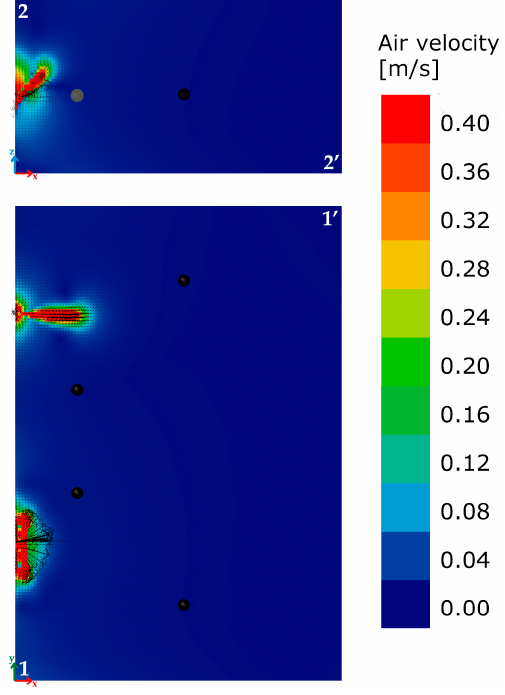
Figure 9. Optimized situation: air velocity distribution for sections 1-1’ and 2-2’.